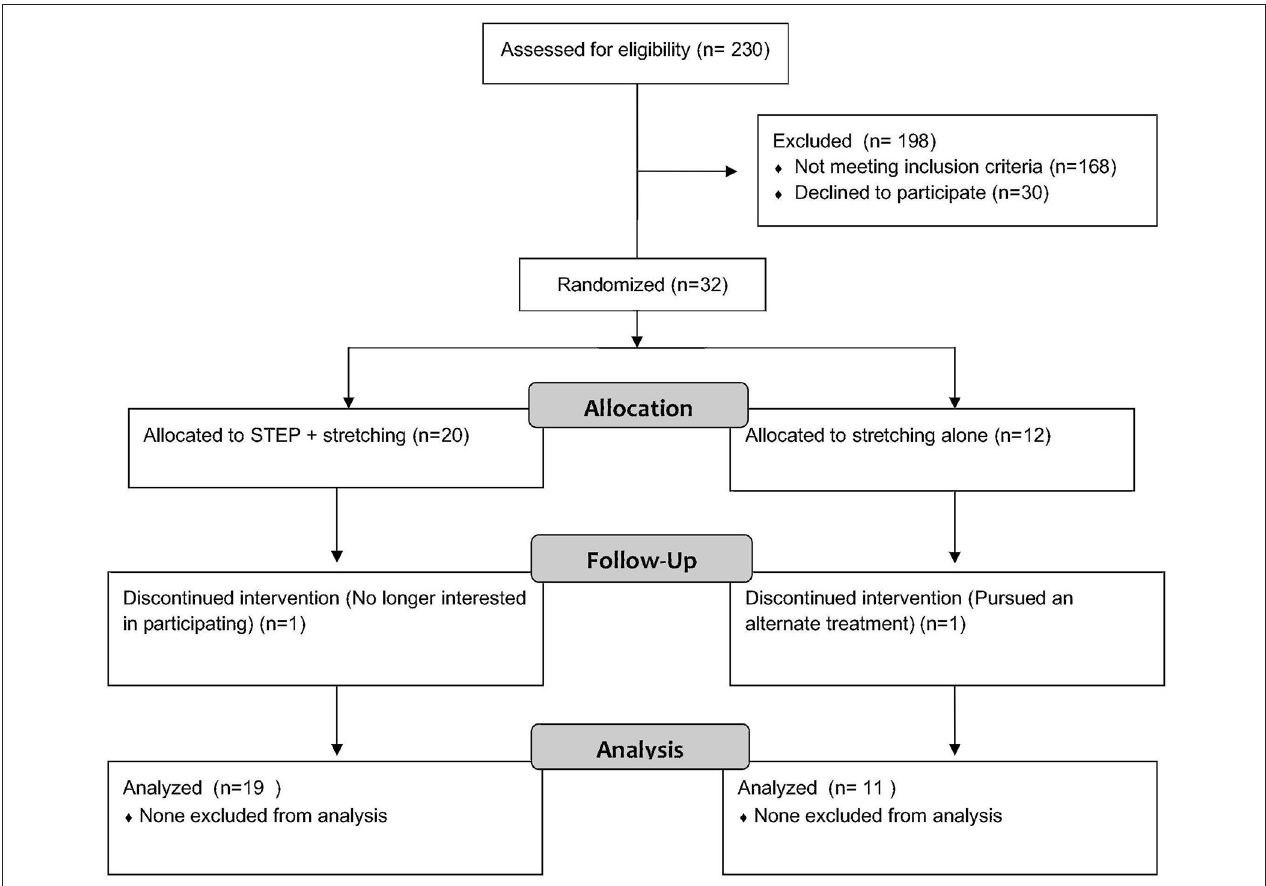
FIGURE 2 | CONSORT flow diagram for Sub-Threshold Exercise Program (STEP), Seattle WA